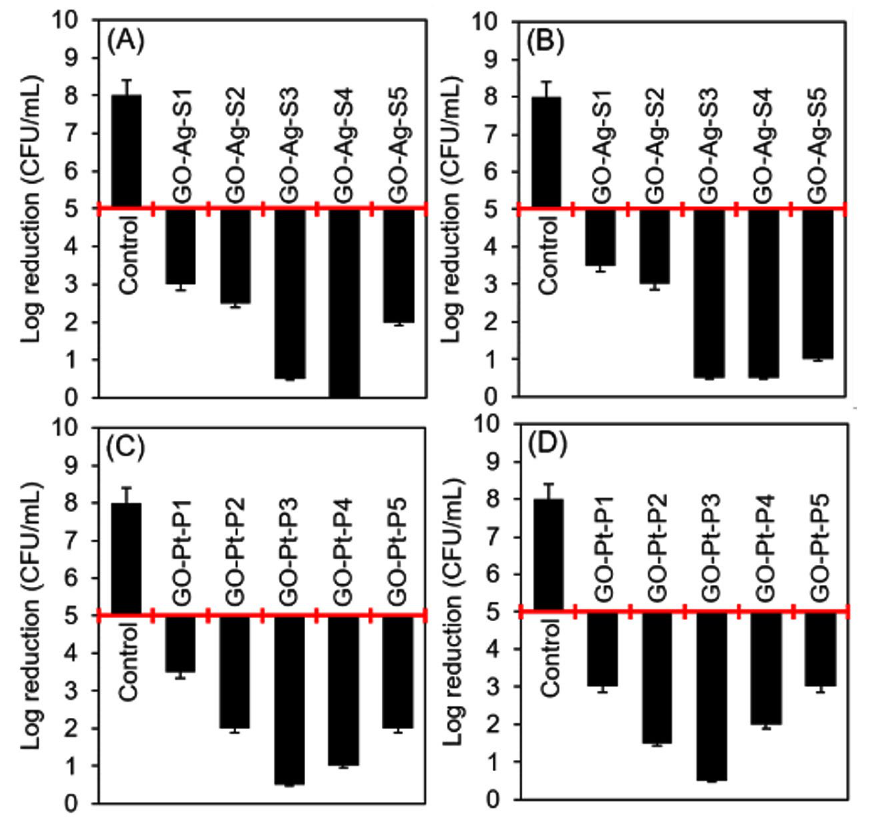
Fig. 10. Evaluation of the antibacterial activities of silver and platinum nanoparticles loaded graphene-bio- composites. (A) and (B) are representing the antibacterial attributes of silver nanoparticles loaded bio-composites against B. subtilis , and E. coli , respectively. (C) and (D) are representing the antibacterial attributes of platinum nanoparticles loaded bio-composites against B. subtilis , and E. coli , respectively. The reduction in the initial bacterial count i.e. 1.5 × 10 8 CFU/mL showed bacteriostatic and bactericidal activities of the respective samples. A 2-log reduction was considered to claim an antibacterial